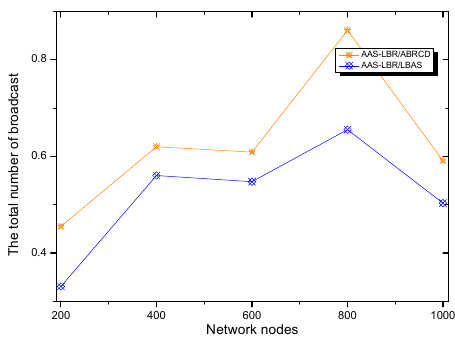
Figure 40. The impact of network size with fixed value of |𝑇| = 90 on the total number of broadcast.